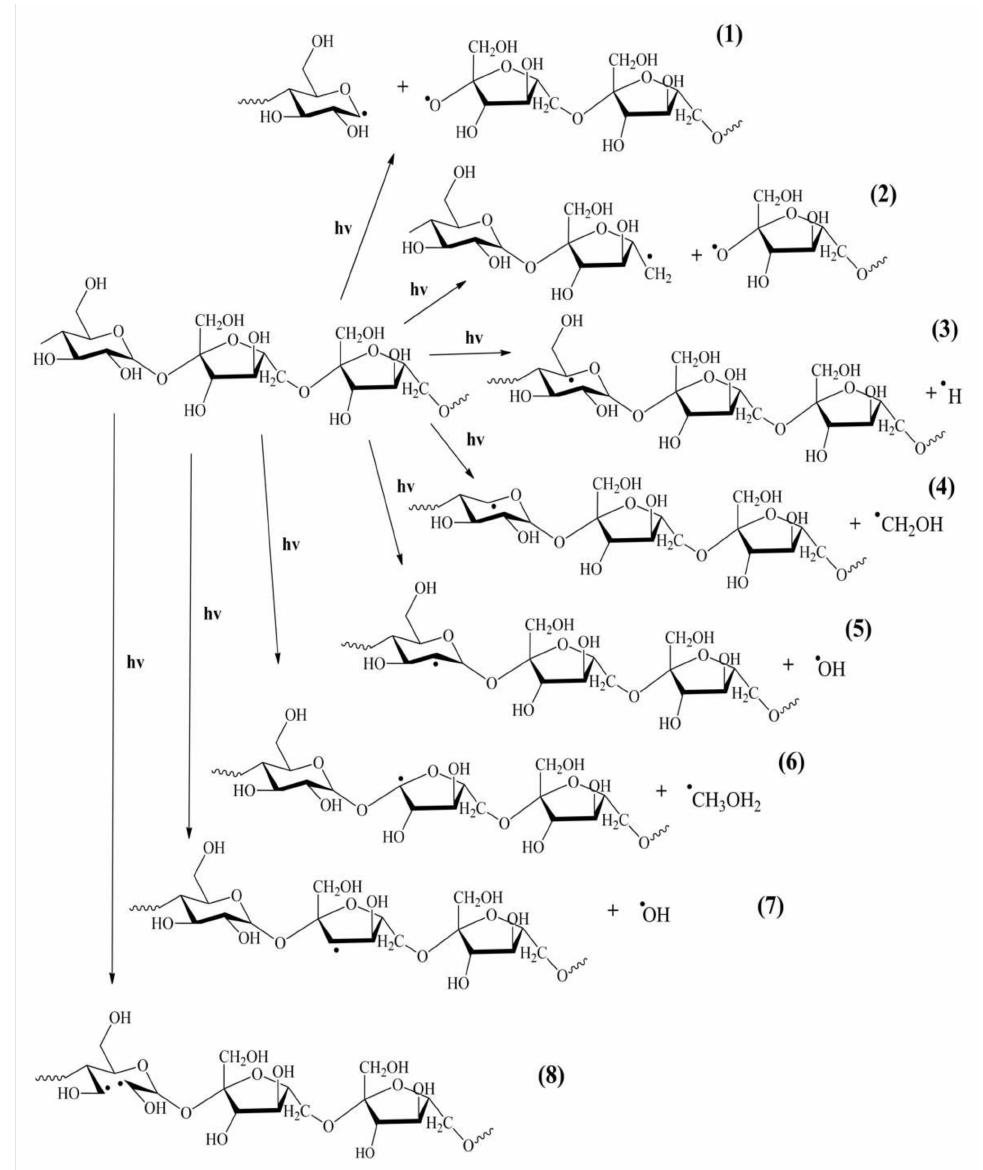
Figure 6. Main photochemical reactions in the levan. Under UV irradiation, there are changes in the chemical structure of macromolecules and the formation of low molecular weight degradation products [27]. Secondary reactions can occur differently due to the presence of several active intermediates. Deactivation of all radicals leads to the termination of the process. This happens mainly through radical recombination or disproportionation